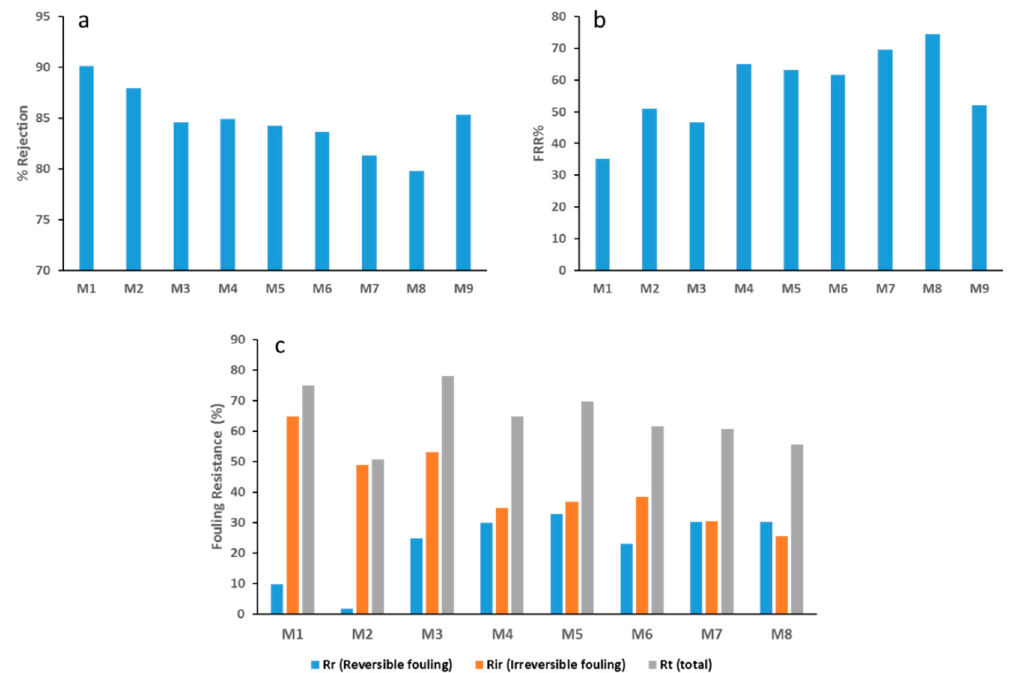
Figure 11. Rejection and fouling data for PES/GO membranes. ( a ) BSA rejection values, ( b ) FRR (flux recovery ratio) % for different membranes and ( c ) the different types of fouling from the BSA solution filtration tests.